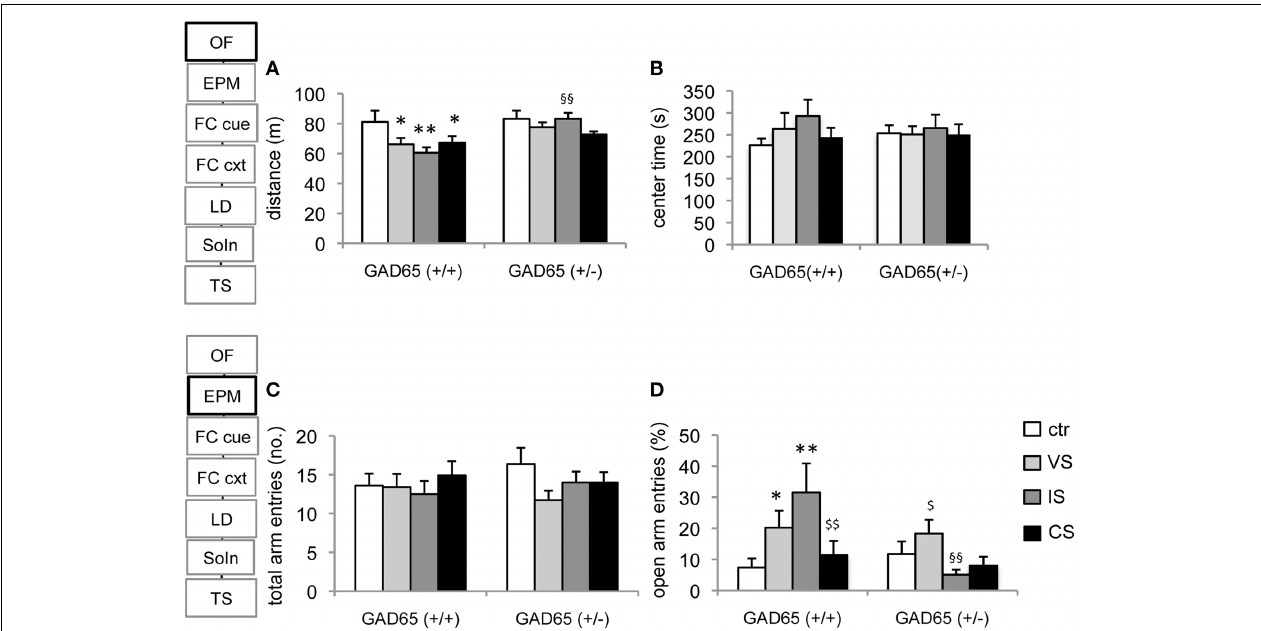
FIGURE 1 | Open field and elevated plus maze. (A) All three stress procedures led to a significant reduction in activity in the open field in GAD65( + / + ) but not in GAD65( + / − ) mice in the OF. Socially isolated wild type mice differed significantly from their heterozygous littermates of the same group. (B) No behavioral alterations were observed with respect to the time spent in the center. (C) In the EPM no differences were observed in total arm entries in either genotype or stress group. (D) Heterogeneous results were obtained in the percentage of open